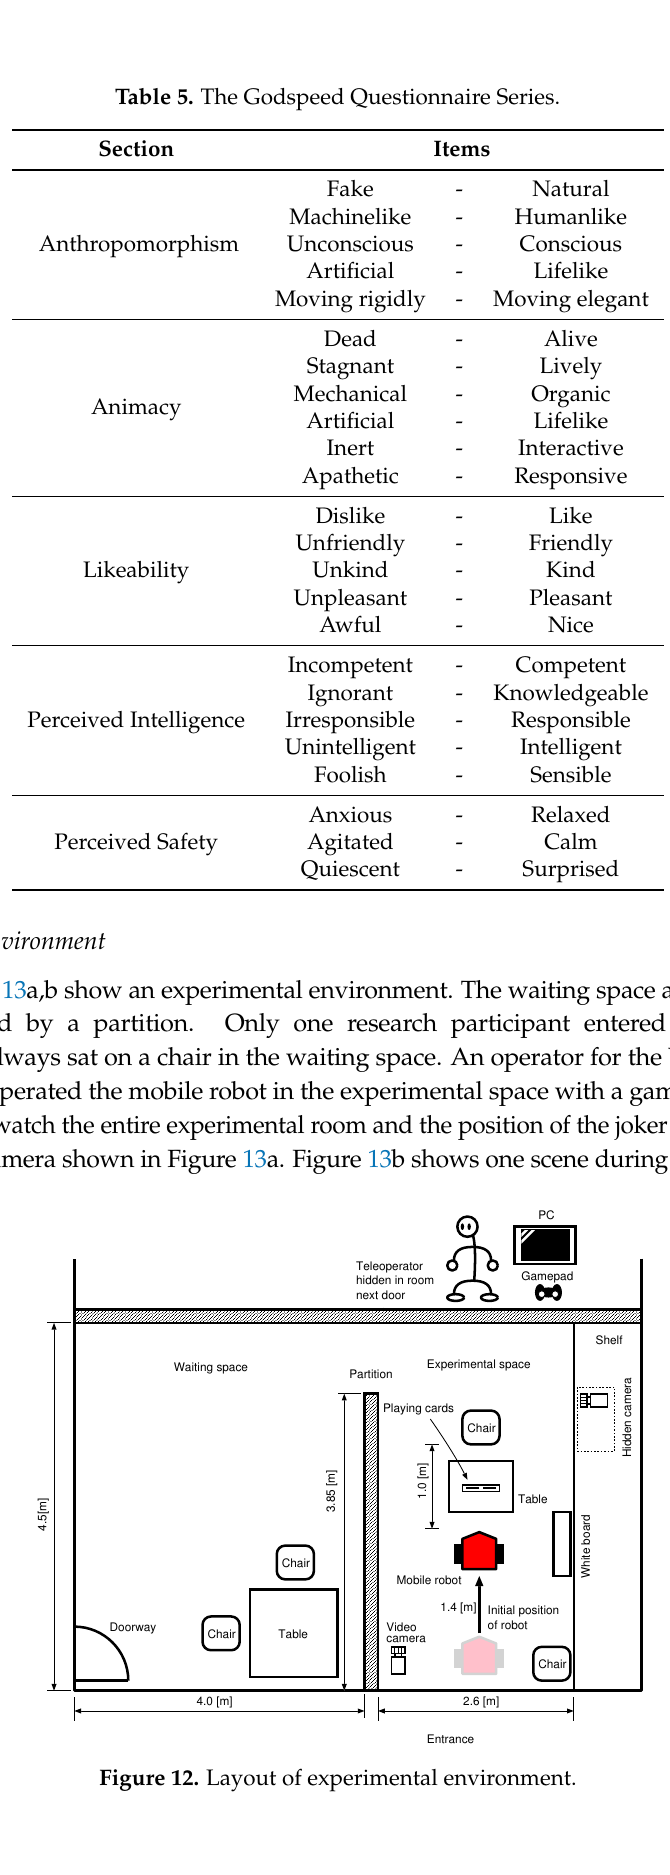
Figure 12. Layout of experimental